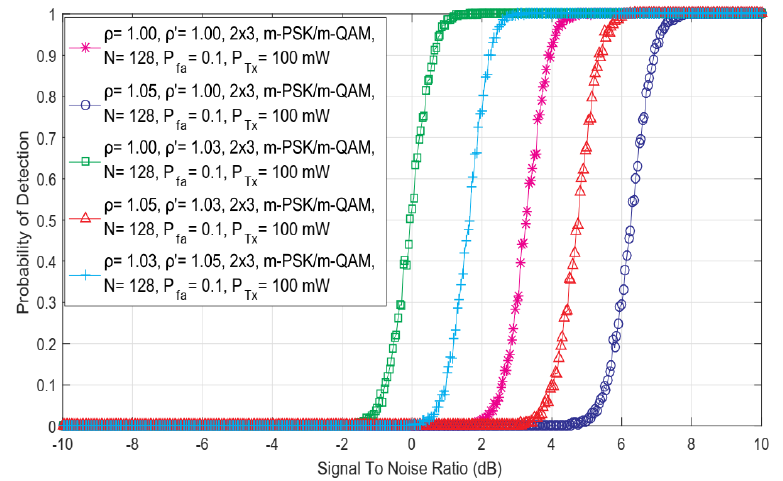
Figure 3. The dependency of detection probability on SNR for ED performed with different combinations of DDT and NU factors in asymmetric 2 × 3 MIMO communication system.